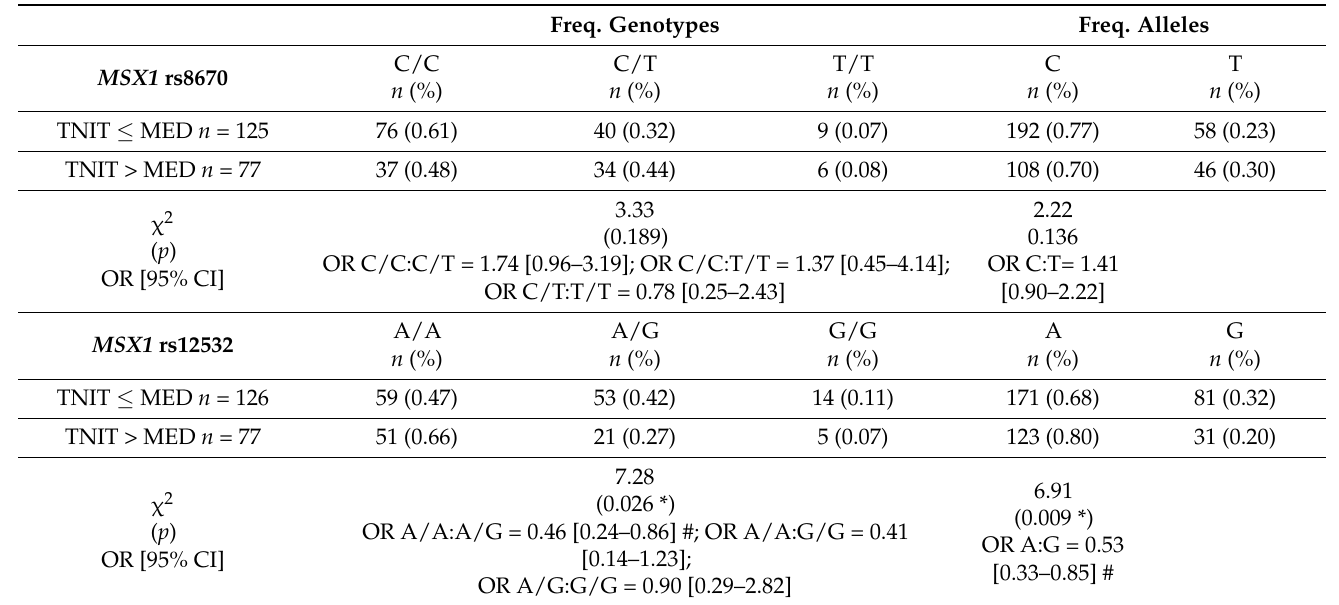
Table 7. Genotypes and alleles described for MSX1 rs8670 and rs12532 variants in the subgroups of patients with a total number of impacted teeth below (TNIT ≤ MED) and above (TNIT > MED) median value. Freq. Genotypes Freq. Alleles